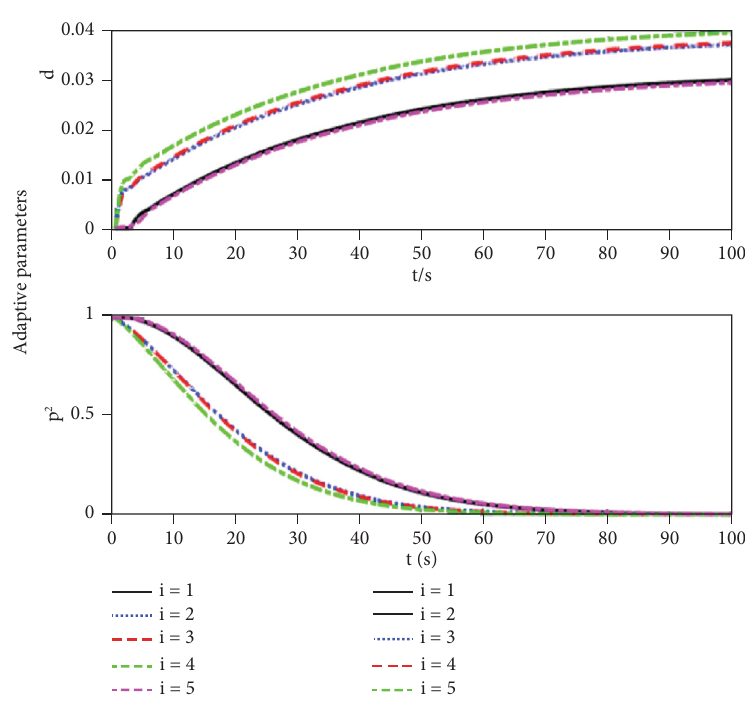
Figure 5: Adaptive parameters ̂ d